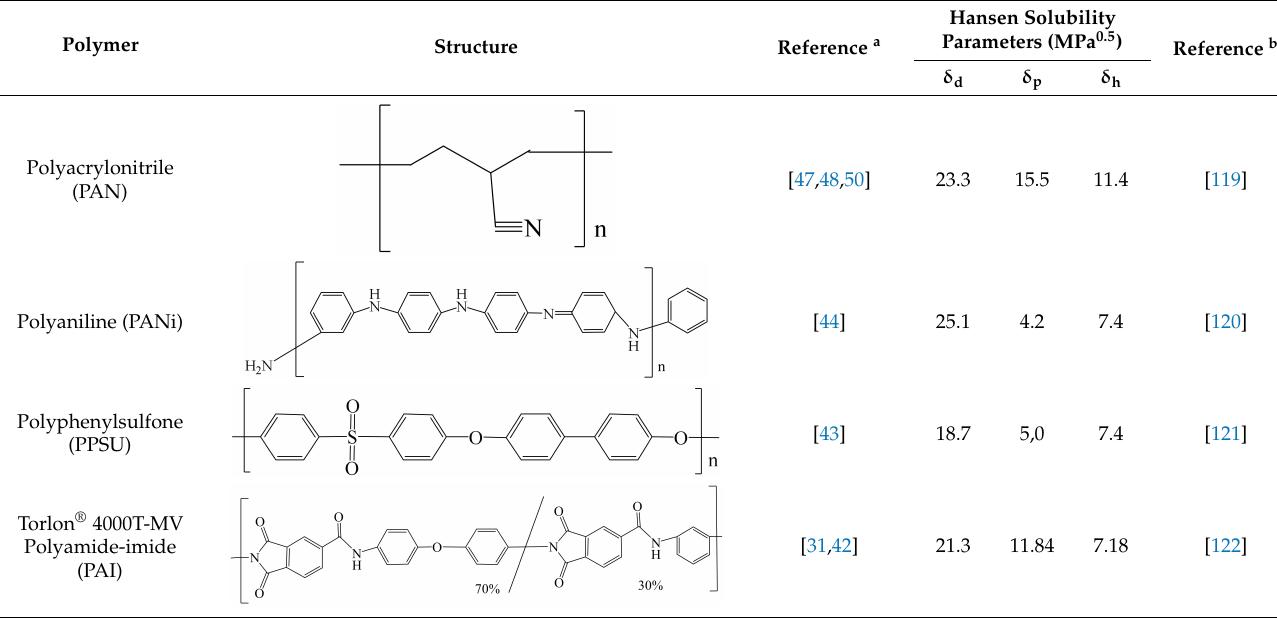
Table 6. Molecular masses (M), molar volumes (MV), boiling temperature (T b ), densities ( ρ 25 ◦ C